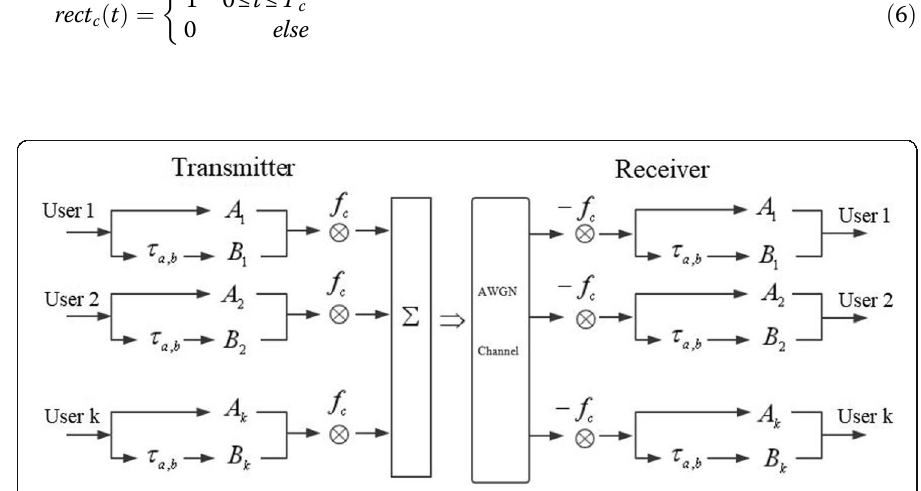
Fig. 3 Structure diagram of spread spectrum system simulation model based on complete complementary sequence pair. The structure of spread spectrum system based on complete complementary sequence